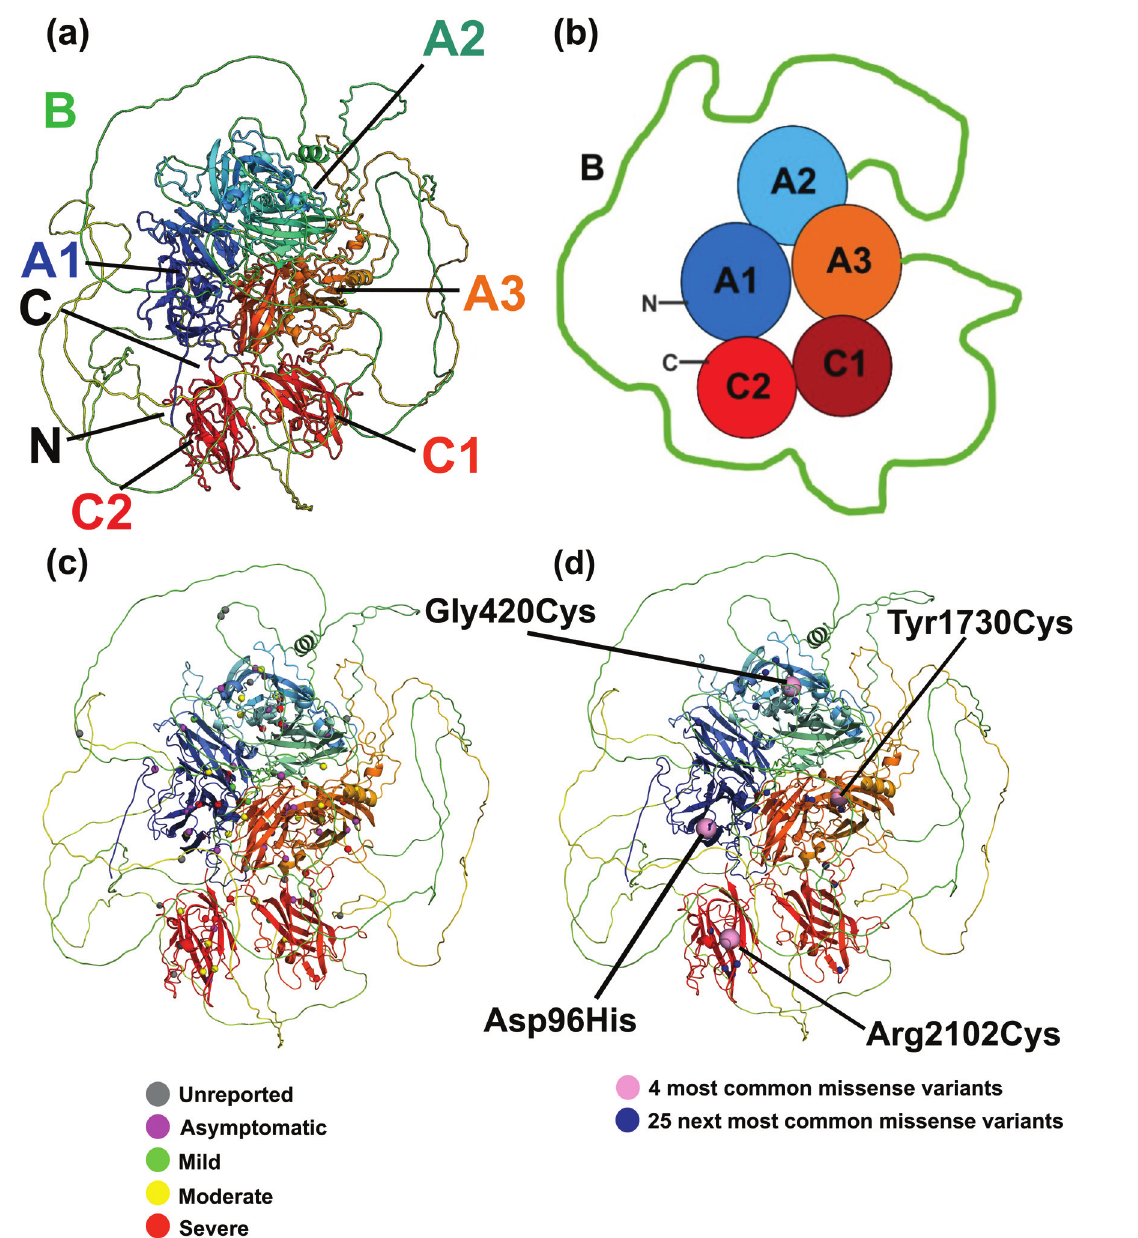
Fig. 3 Structural and schematic views of FV de fi ciency variants within the FV domains. ( a ) The full FV structure is shown in ribbon format from the AlphaFold prediction. The structure is shown in rainbow colors, with blue corresponding to the N-terminal region and red corresponding to the C- terminal region. The N-terminus and C-terminus are denoted by N and C, respectively. ( b ) The FV structure from ( a ) is shown schematically in cartoon form in the same orientation and colors. The globular A1, A2, A3, C1, and C2 domains are denoted by fi lled circles. The disordered B domain is schematically represented by a green line. ( c ) The 100 missense variants are mapped to the ribbon diagram, where the phenotype classi fi cations of mild, moderate, and severe effects are denoted as the traf fi c light colors of green, yellow, and red, respectively. Missense variants with unreported phenotype are shown in gray and asymptomatic cases are shown in purple. ( d ) The 25 most commonly reported variants are shown as spheres in the ribbon structure of FV shown in ( a ). Blue spheres denote the fi fth to twenty- fi fth more common variants, and the four magenta spheres denote the four most common variants in FV ( ► Supplementary Fig. S3 below). FV, Factor V.